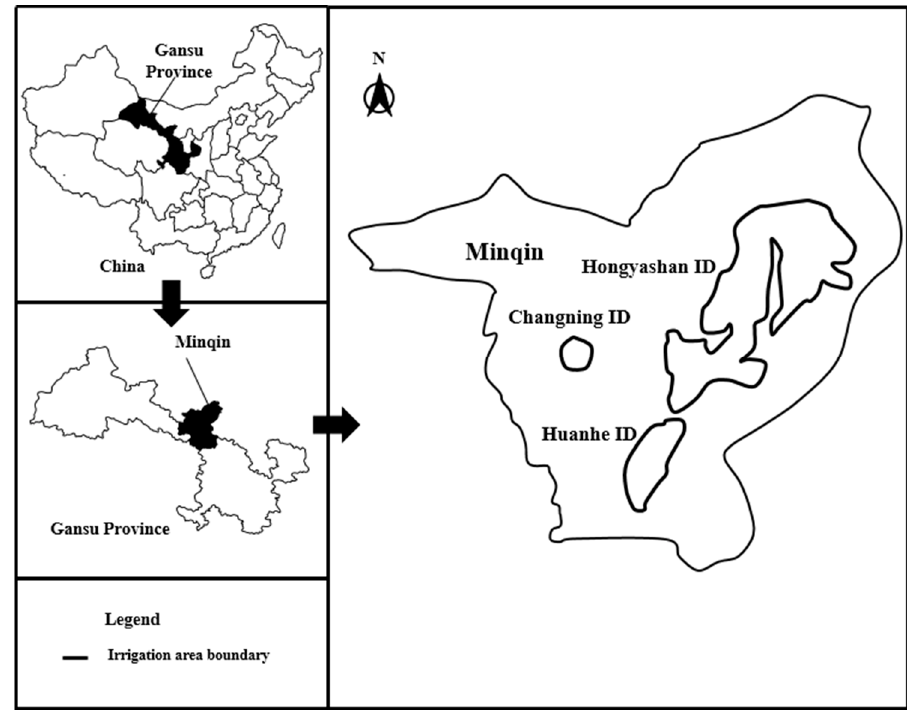
Figure 2. Study area.